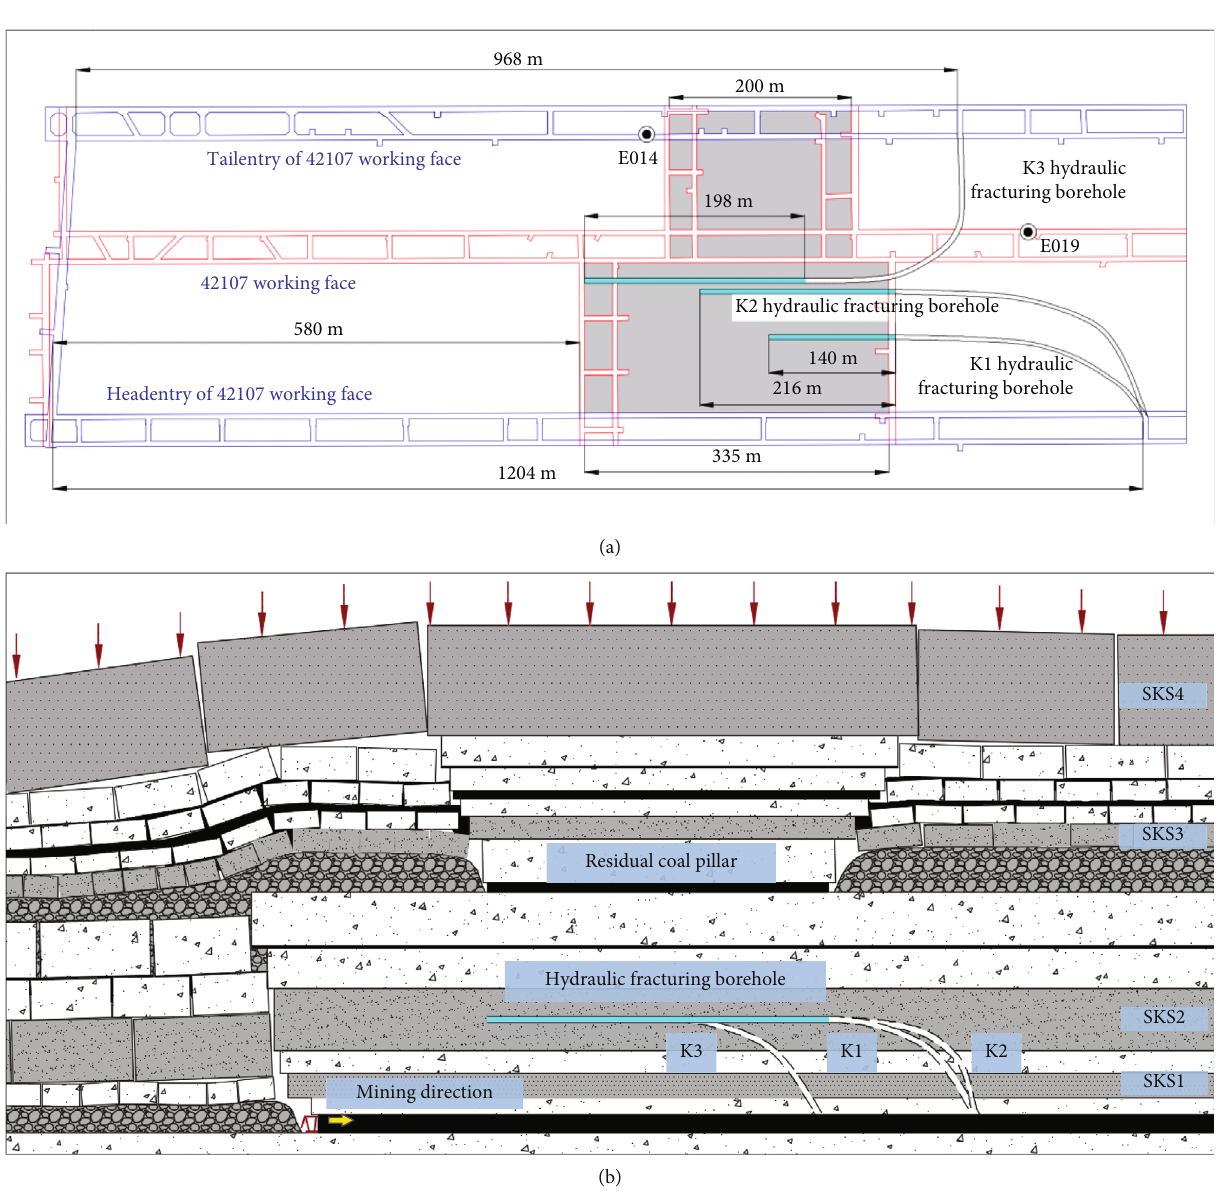
Figure 12: Hydraulic fracturing scheme: (a) plane graph and (b) section